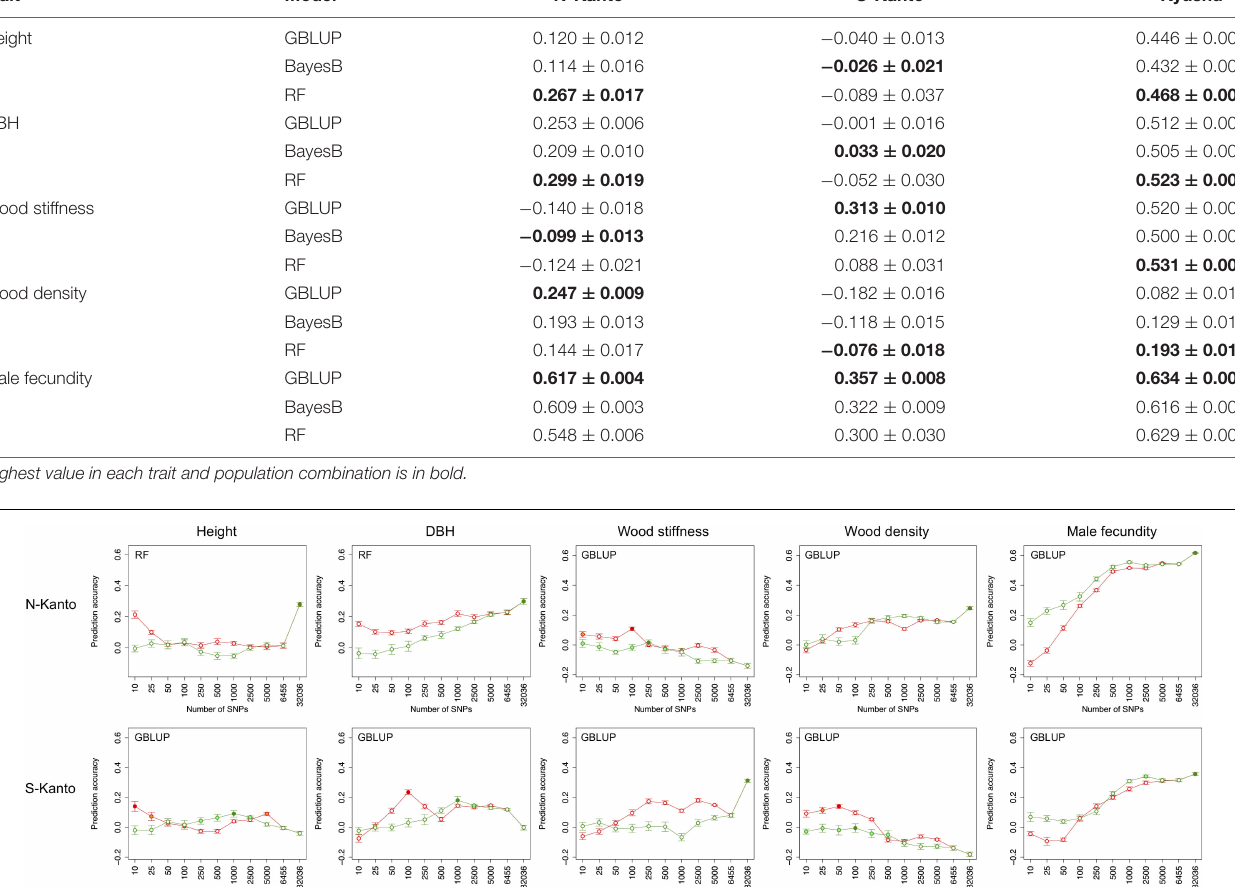
TABLE 3 | Mean ( ± SE) accuracies based on all 32,036 SNPs. Trait